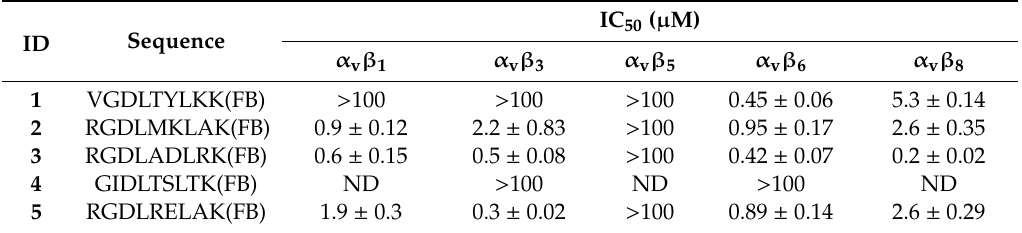
Table 1. ELISA data showing the relative binding a ffi nity and selectivity of lead peptides measured by IC 50 values ( n = 3).